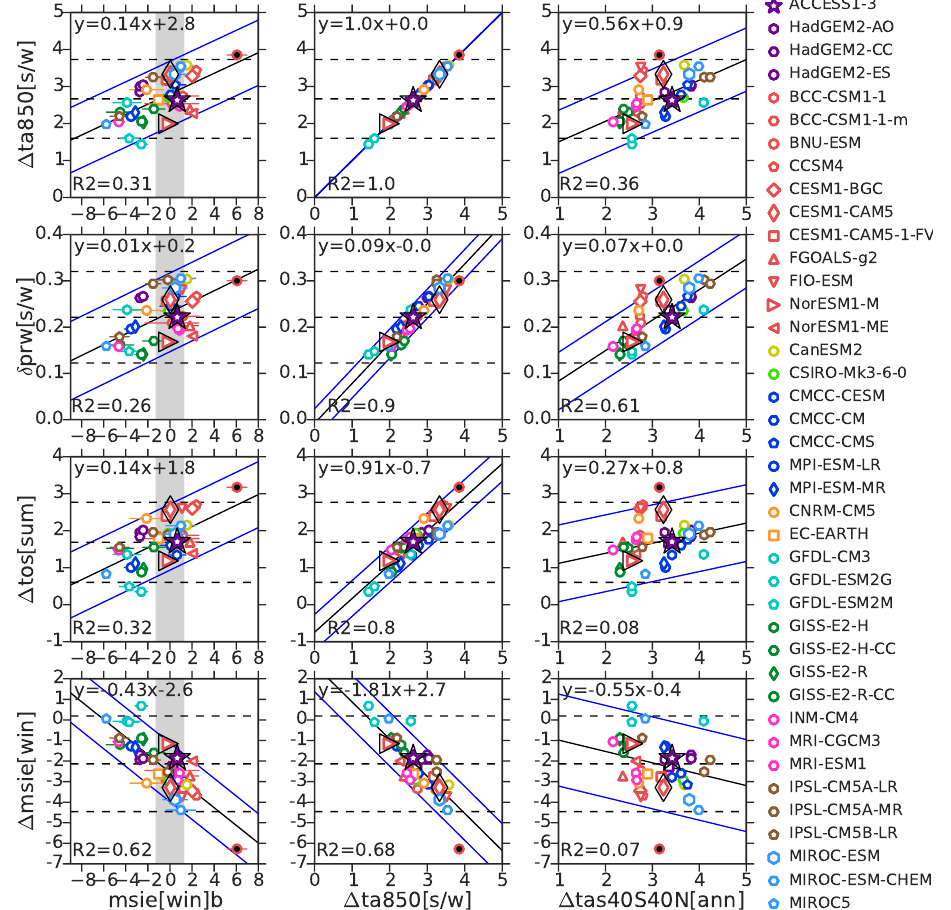
Figure 3. Y axes: evolution in time (2070–2100 minus 1980–2010) of summer/winter 850hPa air temperature ( (cid:49) ta850[s / w]), summer/winter precipitable water ( δ prw[s / w]), summer sea surface temperature ( (cid:49) tos[sum]) and winter meridional sea-ice extent scaled by ERA-Interim standard deviation of annual values ( (cid:49) msie[win]). The (cid:49) symbol is for absolute differences and the δ symbol for absolute differences divided by 1980–2010 mean value. X axes: winter msie bias (msie[win]b), (cid:49) ta850[s / w] and evolution in time of annual surface air temperature between 40 ◦ S and 40 ◦ N ( (cid:49) tas40S40N[ann]). Horizontal coloured lines in the first column are 2 times the multi-decadal variability of msie[win]b, and the grey band width is 2 times the 90th percentile of msie[win]b multi-decadal variabilities. Solid black lines are regression lines computed without considering the outlier BNU-ESM (red dot with black face colour). Blue lines are vertical shift of the regression line by 1.96 standard deviation of residuals. Three of the five highest-scores models are highlighted with black contours: ACCESS1-3 (star), CESM1-CAM5 (thin diamond), and NorESM1-M (triangle). Models with obvious similarities in code or produced by the same institution are marked with the same colour, following Knutti et al.